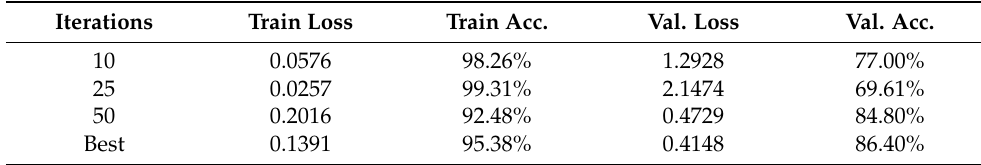
Table 7. Comparison of experimental results using the typical classification methods for three classes of Arabic comments.